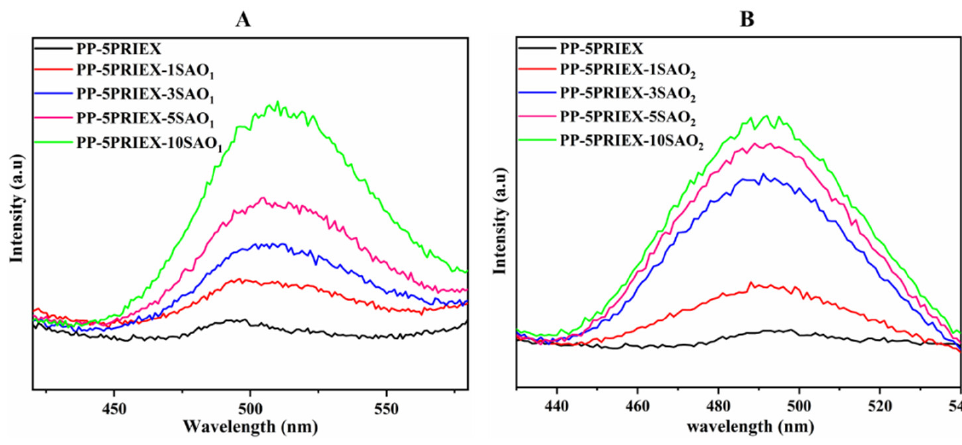
Figure 6. The phosphorescence emission spectra of PP/5PRIEX/SAO 1 ( A ) and PP/5PRIEX / SAO 2 ( B ) composites.